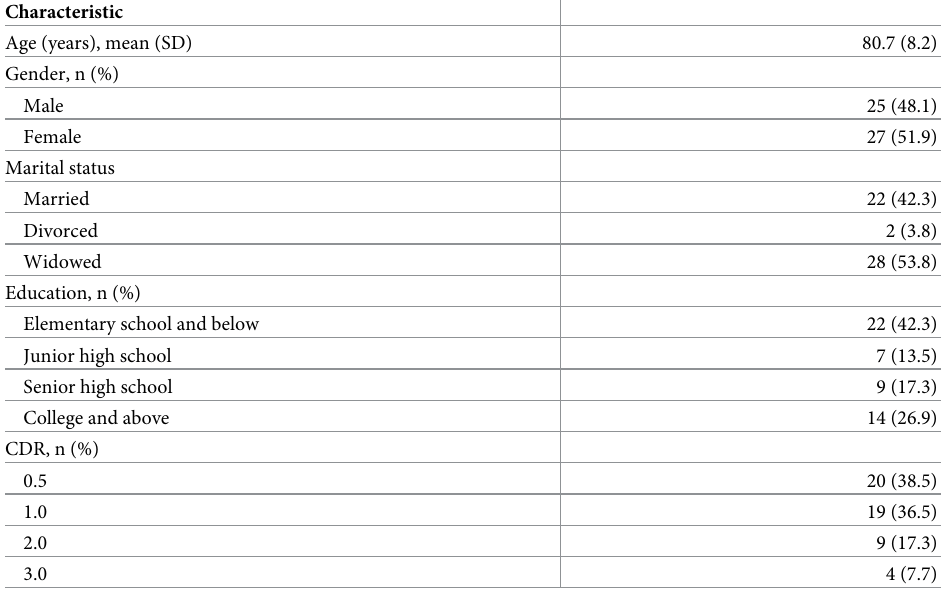
Table 1. Demographics and clinical characteristics of participants (n = 52).